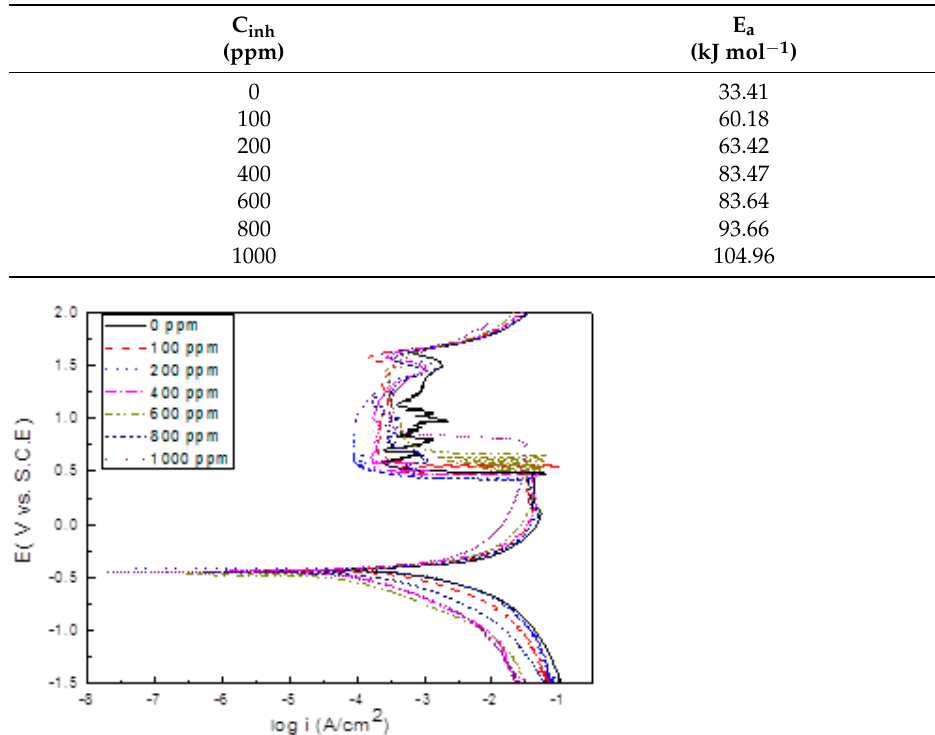
Figure 4. Arrhenius E a activation energy plots for carbon steel in 0.5 M H 2 SO 4 containing different concentrations of α -linolenic acid. Table 1. Effect of α -linolenic acid concentration on the activation energy for 1018 carbon steel in 0.5 M H 2 SO 4 .